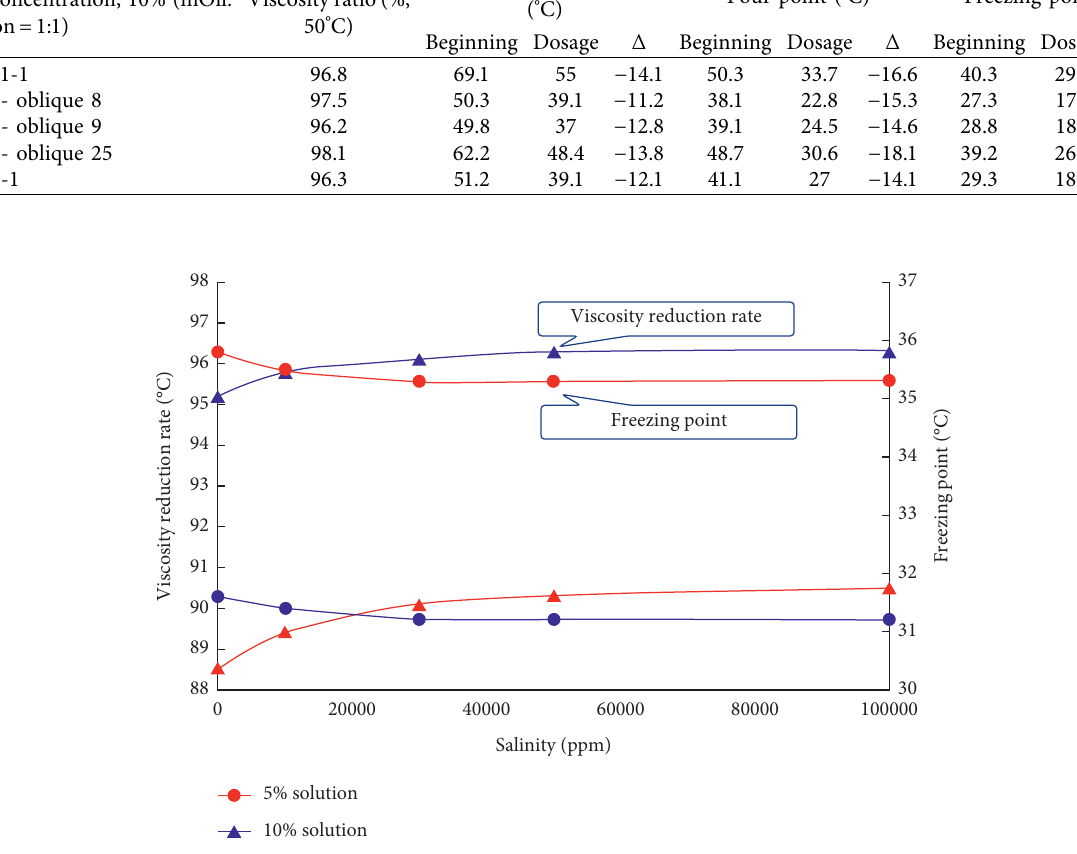
Table 5: Adaptability test for viscosity reduction and wax suppression of the compound system 7. Drug concentration, 10%